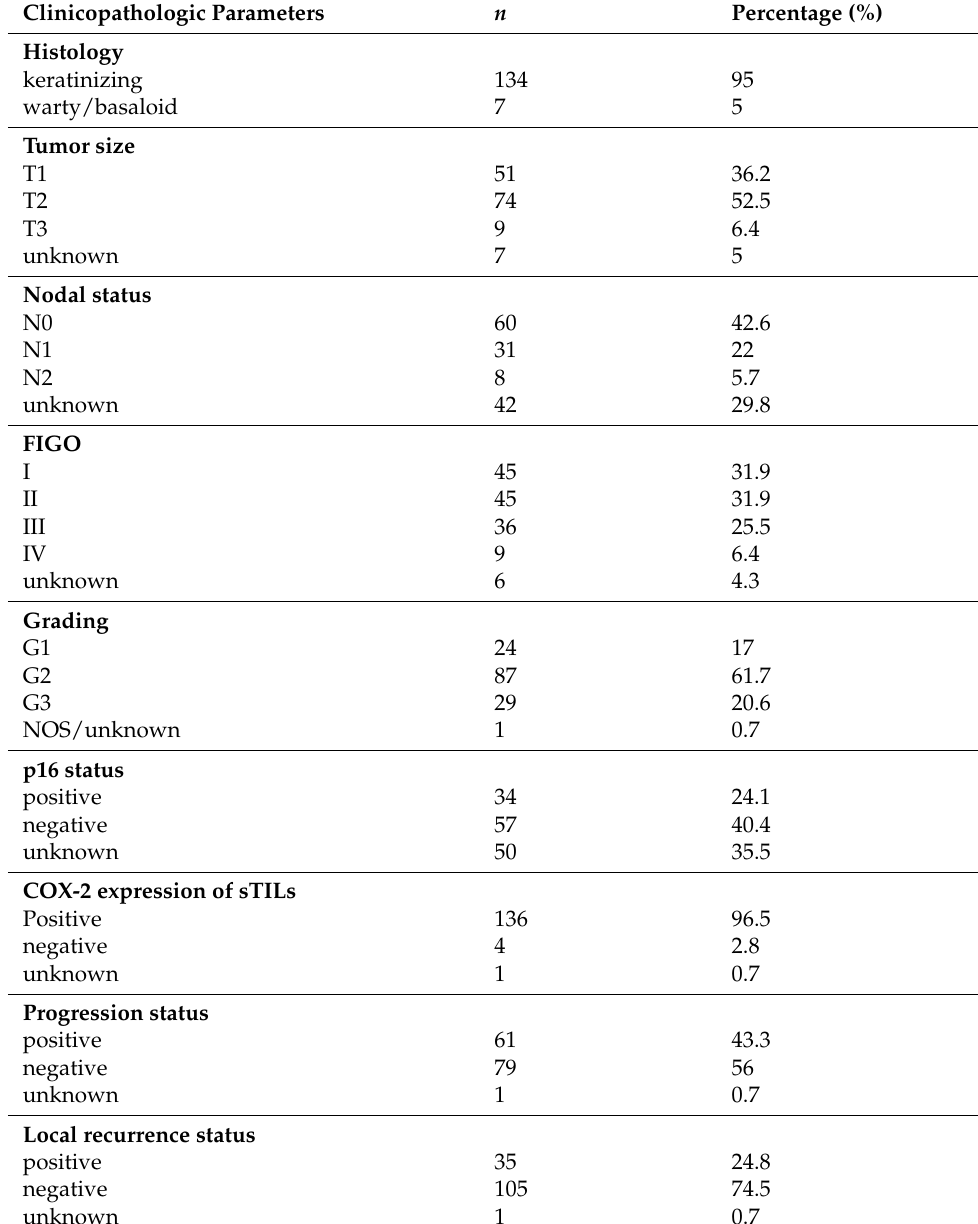
Table 3. Clinicopathological parameters of VSCC patients’